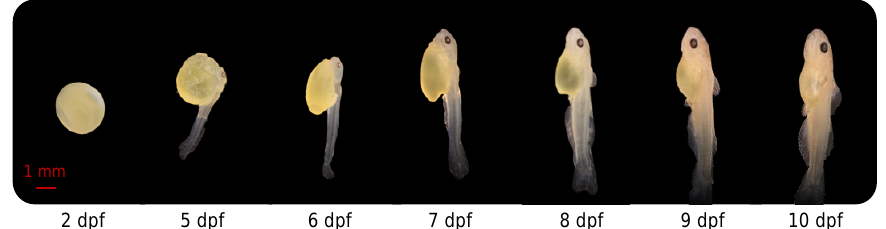
Figure 1. Morphology of the channel catfish, Ictalurus punctatus , at different development stages. dpf: days post fertilization .